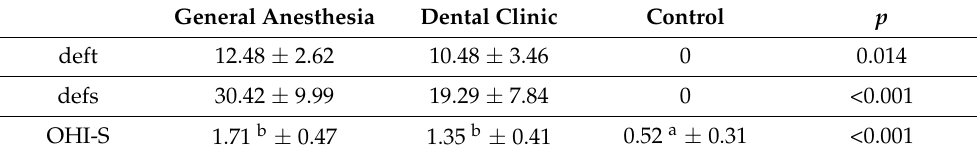
Table 2. Mean deft, defs, and OHI-S indices of the groups (Mean ± Standard Deviation). General Anesthesia Dental Clinic